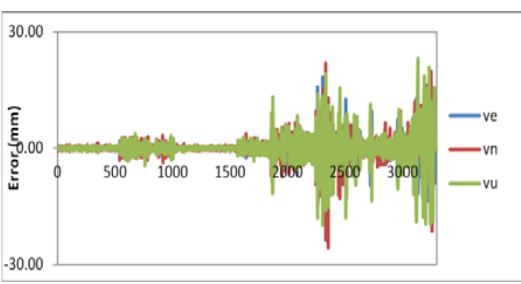
Figure 4. Altitude estimation results difference from EKF results